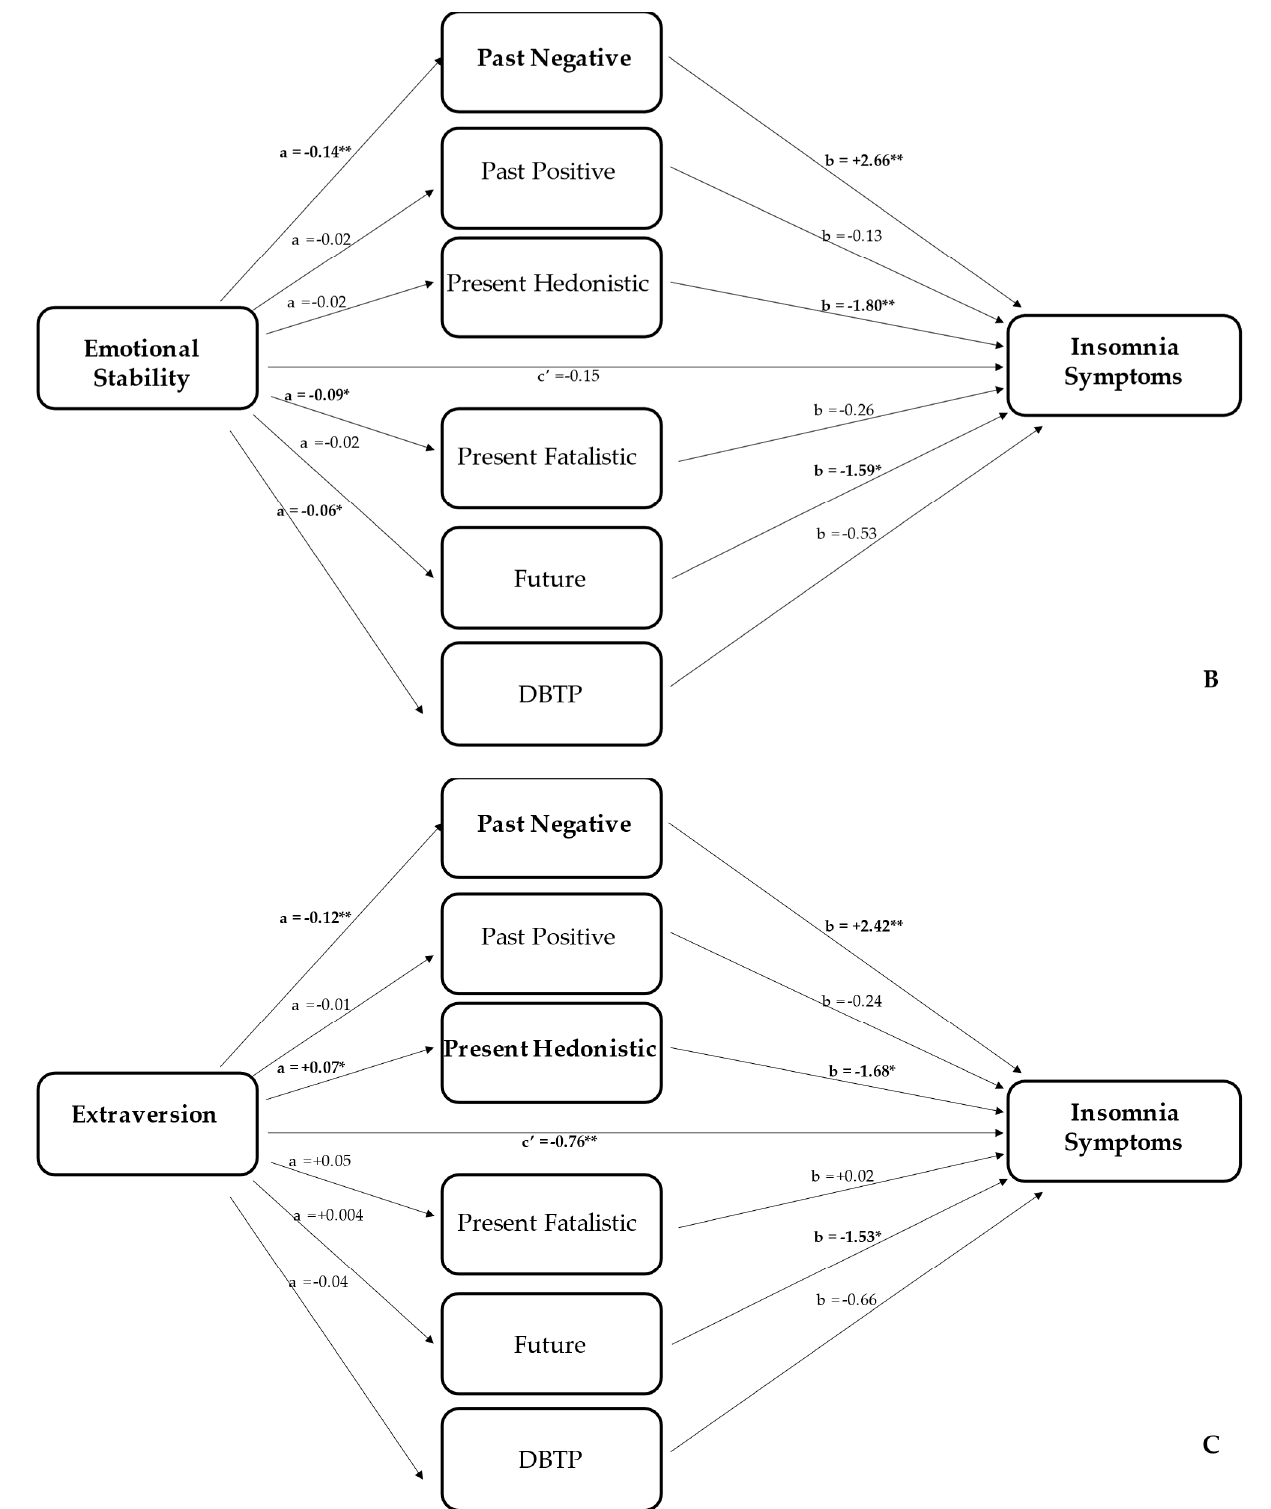
Figure 2. ( A ) The mediation model with conscientiousness as a predictor of ISI score with all TPs as mediators; ( B ) the mediation model with emotional stability as a predictor of ISI score with all TPs as mediators; ( C ) the mediation model with extraversion as a predictor of ISI score with all TPs as mediators. In all figures, the significant relationships are in bold; * indicates p < 0.05, while ** indicates p < 0.0001.